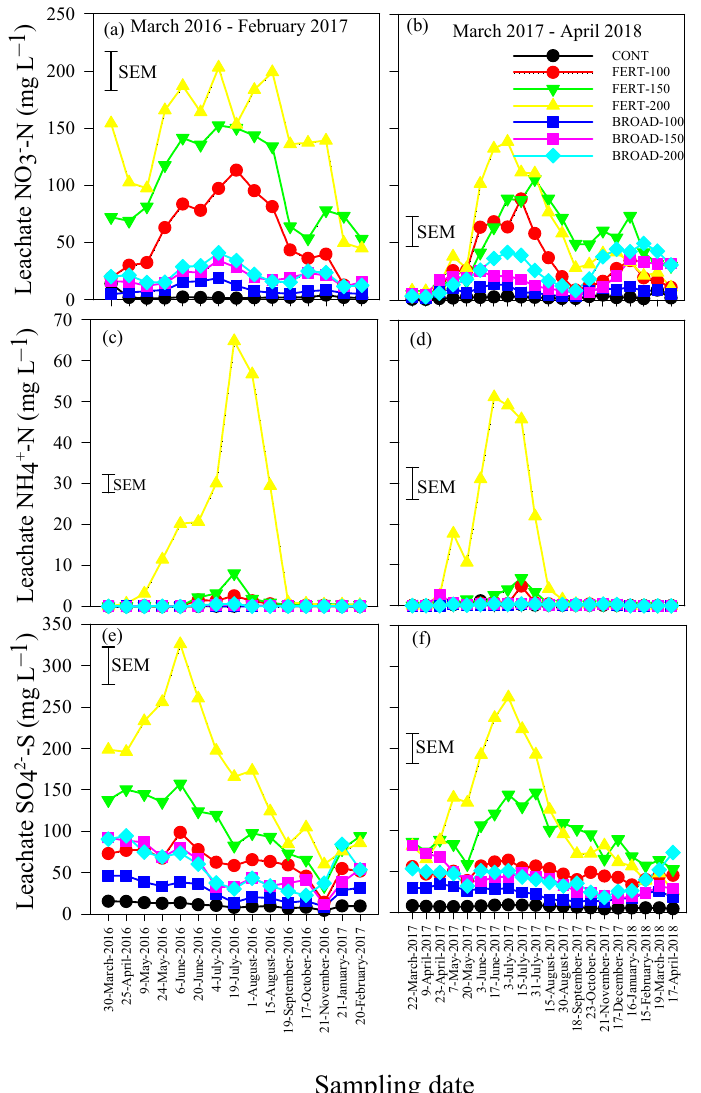
Figure 2. Concentrations of ( a , b ) nitrate nitrogen (NO 3 -N), ( c , d ) ammonium nitrogen (NH 4 -N) and ( e , f ) sulfate sulfur (SO 4 -S) in the leachate collected at 76 cm soil depth with annual applications of N through the fertigation (FERT-100, 100%; FERT-150, 150%; FERT-200, 200%) and broadcast (BROAD-100, 100%; BROAD-150, 150%; BROAD-200, 200%) methods to highbush blueberry ( Vaccinium corymbosum ) for two consecutive years (March 2016–February 2017 and March 2017–April 2018). Error bars represent the standard errors of the means (SEM) for comparing all values (n = 420 and df = 294).